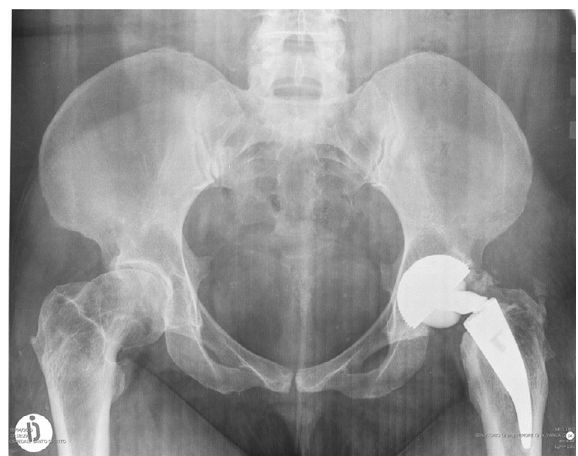
Figure 1. Neck-stem junction breaking in the absence of traumatic injury after two years from the 1st THA (Total Hip Arthroplasty). The prosthesis is a Metha stem implant with modular neck. It was implanted in 2006 when the corrosion theory was not known and the modular neck was in titanium without CrCo.